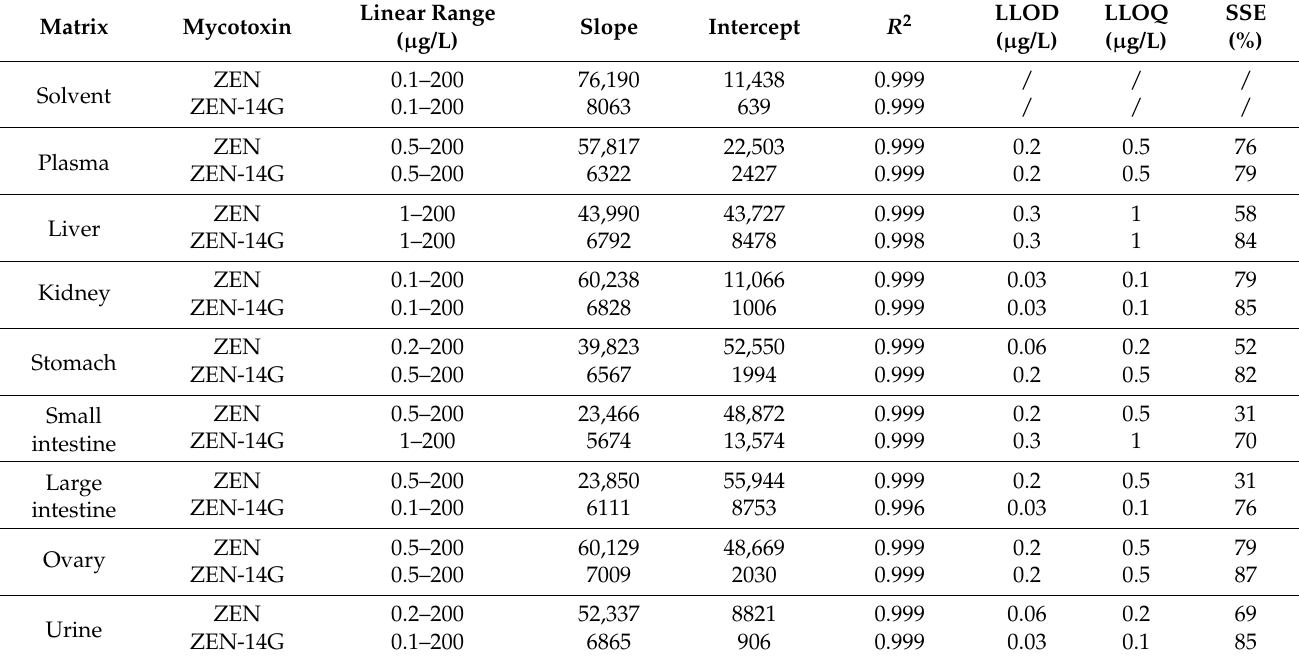
Table 2. Linearity, lower limit of detection (LLOD), lower limit of quantification (LLOQ), and matrix effect (SSE) of zearalenone (ZEN) and zearalenone-14-glucoside